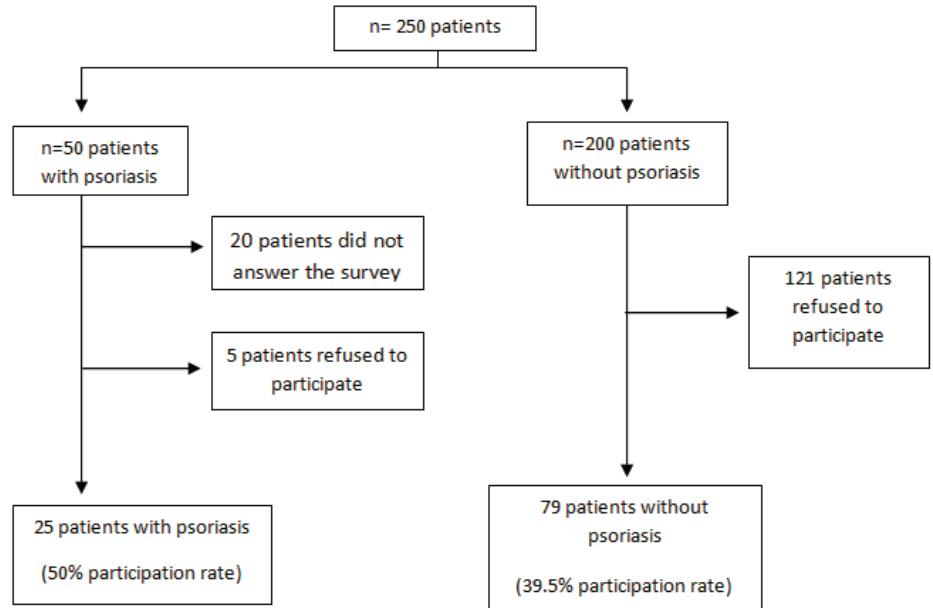
Figure 1. Organizational chart of patients with psoriasis and without